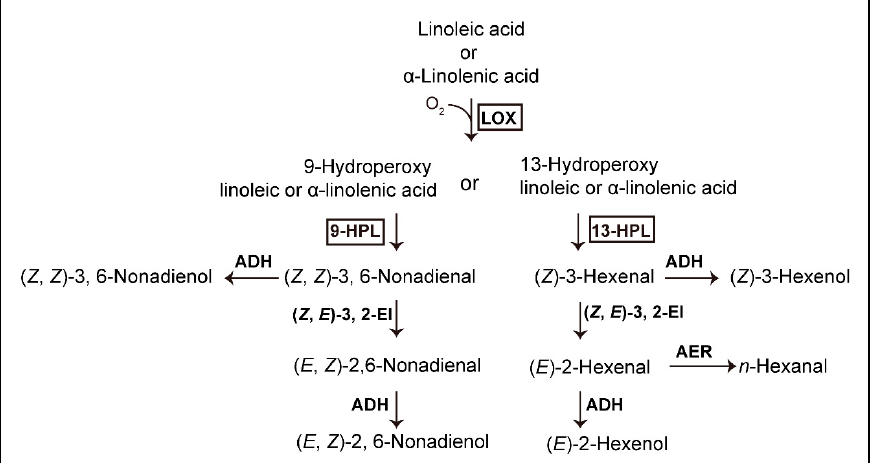
Figure 1. Biosynthesis of selected flavor compounds derived from fatty acids (modified from Schwab et al., (2008) [11]). ADH, alcohol dehydrogenase; AER, alkenal oxidoreductase; HPL,